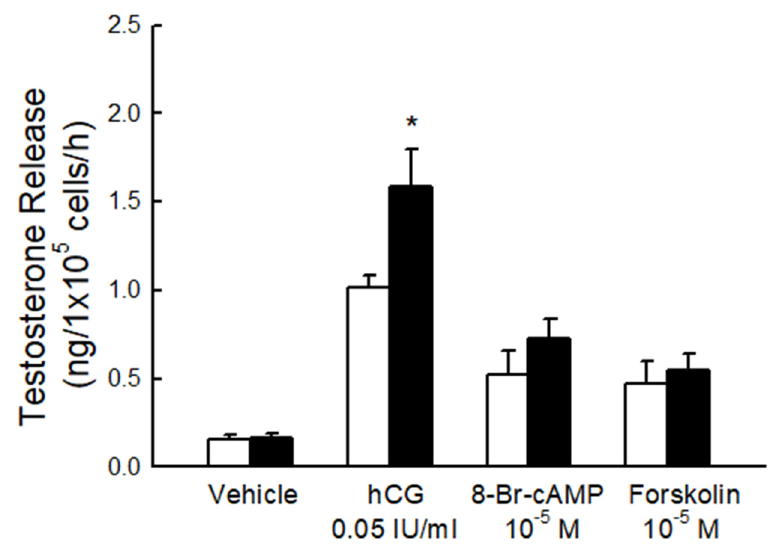
Figure 3. Testosterone release in response to different stimulators. Basal and evoked testosterone release in response to hCG, 8-Br-cAMP, or forskolin in rat Leydig cells purified from the fructose-diet fed group (black column) and control group (white column). * p < 0.05 as compared to the control group. Each value presents mean ± SEM. Similar results were repeated twice.